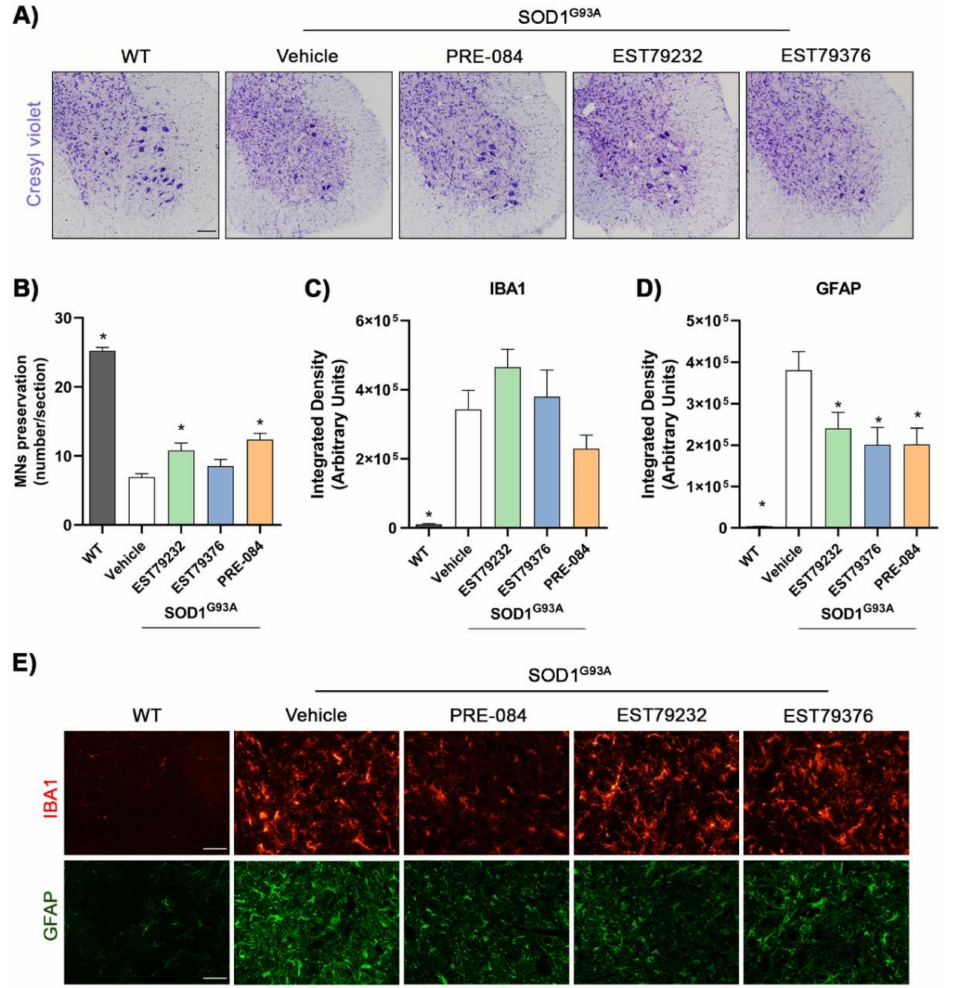
Figure 5. Neuroprotective effects of Sig-1R ligands administration on MNs and glial reactivity in SOD1 G93A mice at 16 weeks. ( A ) Representative images of the ventral horns stained with cresyl violet of WT and SOD1 G93A male mice with or without Sig-1R ligands treatment. Scale bar: 100 µ m. ( B ) Histological analyses showed an increase in number of MNs in mice treated with EST79232 and PRE-084. Animals per group: WT, n = 13; SOD vehicle, n = 16; SOD PRE-084, n = 5; SOD EST79232, n = 7; SOD EST79376, n = 5. ( C , D ) Bar graph showing the integrated density of Iba-1 and GFAP immunolabeling in the ventral horn of spinal cord. n = 5–10 mice per group. Data are expressed as mean ± SEM and analyzed by one-way ANOVA and Bonferroni’s multiple comparisons test. * p < 0.05 vs. SOD1 G93A vehicle mice. ( D ) Representative images of glial reactivity assessed by IBA and GFAP to label microglia and astrocytes in the ventral horn. Scale bar: 50 µ